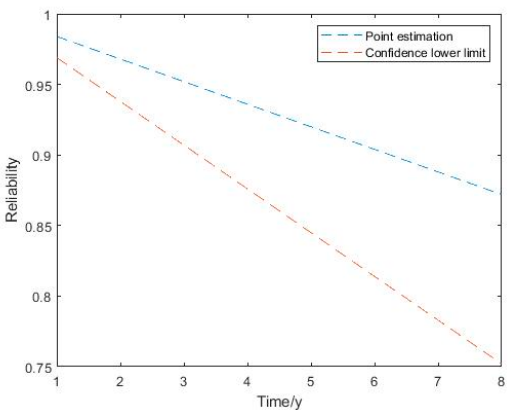
Figure 6. GPS receiver reliability point estimation and confidence lower limit.